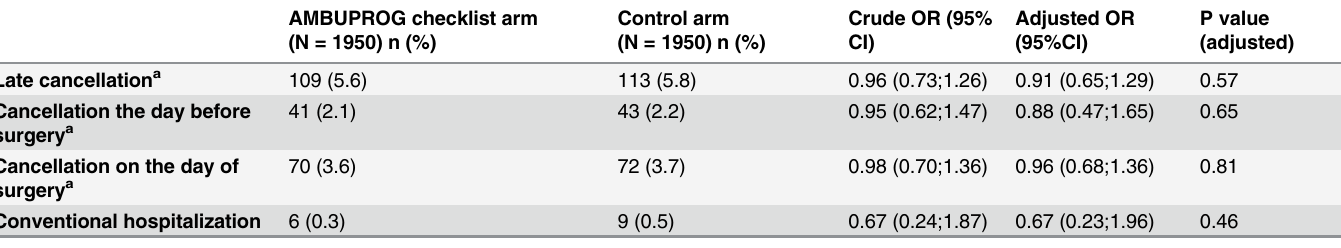
Table 4. Primary and secondary endpoints (n,